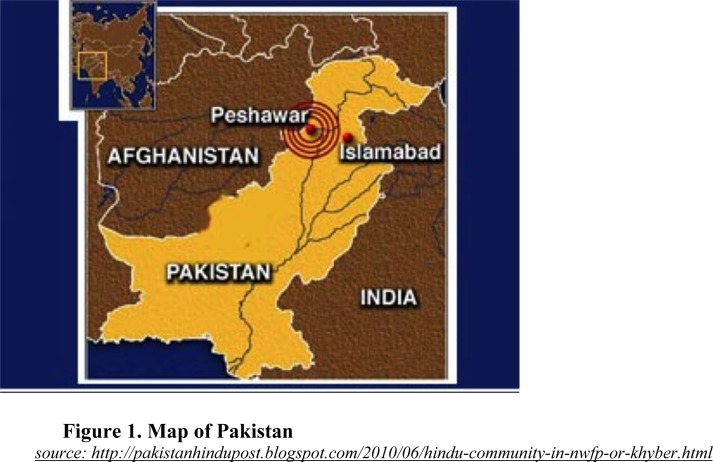
Map of Pakistan.